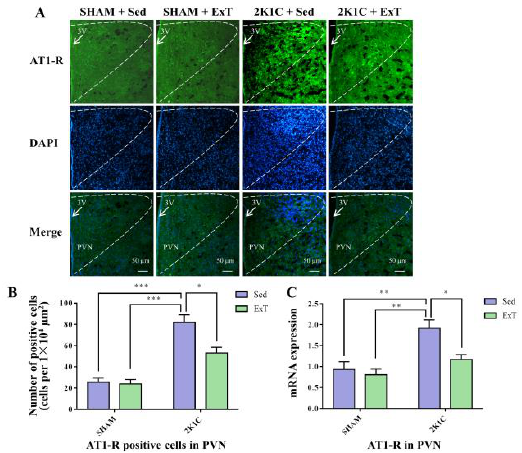
Figure 8. Eight weeks of aerobic ExT attenuated AT-1R immunoreactivity in the PVN of the 2K1C group. ( A ) Representative images of immunofluorescence staining of AT-1R. ( B ) Densitometric analysis of immunoreactivity for AT-1R. ( C ) Densitometric analysis of RT-qPCR of AT-1R. 3V: third ventricle. * p < 0.05, ** p < 0.01, *** p < 0.001, n = 4.